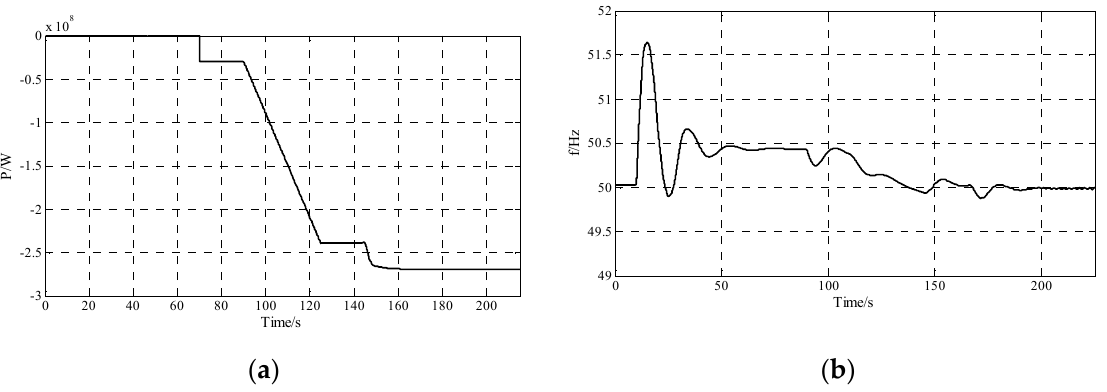
Figure 30. Simulation waveform in pump mode. ( a ) power flow on 18-kV bus; ( b ) the frequency of system.